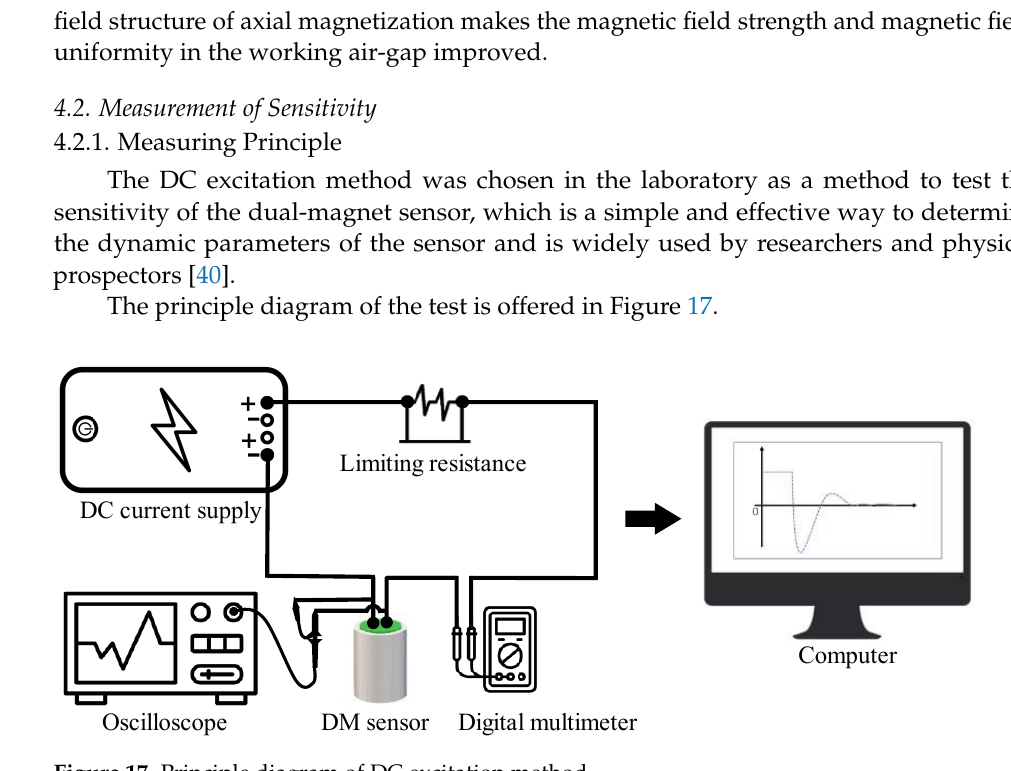
Figure 17. Principle diagram of DC excitation method.